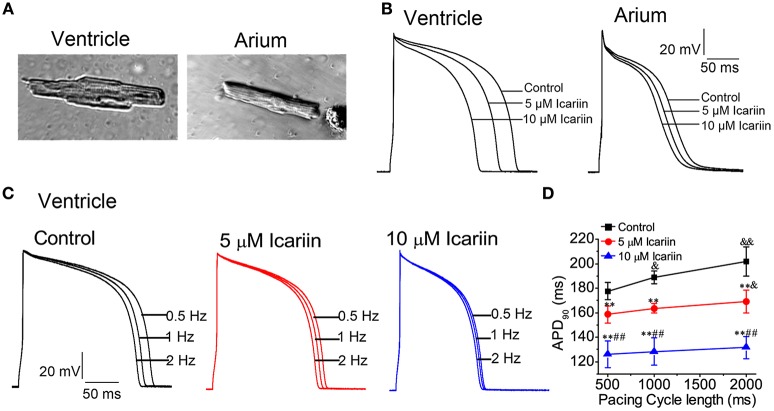
Icariin attenuated APDs in a concentration- and rate-dependent manner in rabbit LVMs and LAMs. (A). Photomicrograph of a single LVM (left) and LAM (right). (B). Effects of icariin (5 and 10 μM) on APs elicited at a stimulation frequency of 1 Hz in LVMs (left) and LAMs (right). (C). Representative recordings of APs elicited at 0.5 Hz, 1 Hz and 2 Hz in the absence and presence of icariin (5 and 10 μM) in ventricular myocytes. (D). Data pertaining to APD90 from 30 sequential curves were averaged. The averaged data for different pacing CLs are shown, n = 9 cells/4 rabbits. & and &&p < 0.05 and 0.01 vs. a pacing CL of 500 ms; **
p < 0.01 vs. control at the same pacing CL; ##p < 0.01 vs. 5 μM icariin at the same pacing CL.